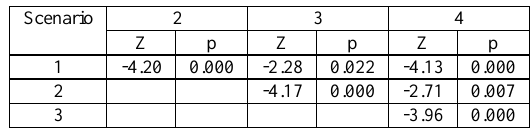
Table 3. Wilcoxon signed-rank test results (non-dominant hand)